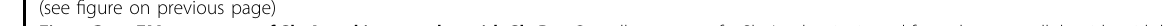
Fig. 1 Cryo-EM structures of SbtA and its complex with SbtB. a Overall structure of a SbtA subunit viewed from the extracellular side with helices shown as cylinders. b Side view of the trimeric structure of SbtA (left) and top view from the intracellular side (right). The gate domains are colored in orange, whereas the core domains are colored in green. The missing residues between Ser166 and Trp212 are indicated as a dashed line. c Cartoon representation of SbtA – SbtB complex structure. Three subunits of SbtB are colored in magentas, red and blue, respectively. The C-terminal disul fi de bond between Cys105 and Cys110 is indicated by blue sticks. An AMP molecule in the nucleotide-binding cleft is shown as yellow sticks. d Interfaces between a pair of SbtA and SbtB subunits. The interacting residues are shown as sticks, with the polar interactions indicated by dashed lines. e The putative Na + -binding site. The Na + is shown as a violet sphere whereas the Na + -binding residues are shown as sticks. The polar interactions are indicated by dashed lines. The cryo-EM density map of Na + is shown in blue mesh. f The putative HCO 3 – -binding site modeled by HADDOCK. The HCO 3 – molecule is shown as sticks and colored by atoms. g The HCO 3 – transport activity assays of the wild-type SbtA and mutants in E. coli membrane vesicles. Three independent experiments were performed for each assay. The means and standard deviations were calculated and the data are presented as means ± SD. Two-tailed Student ’ s t -test is used for the comparison of statistical signi fi cance. The P values of < 0.05 and < 0.01 are indicated with * and **, respectively. h A proposed elevator mechanism of Na + -dependent bicarbonate transport of the trimeric SbtA. The Na + and HCO 3 – are shown as red and blue spheres, respectively. SbtA of an outward-open conformation recruits the substrates HCO 3 – and Na + from the periplasm, accompanied by a rigid-body movement of core domains (green) against the immobile gate domains (yellow). Afterwards, the substrates are released into the cytosol followed by the turnover of SbtA into the resting